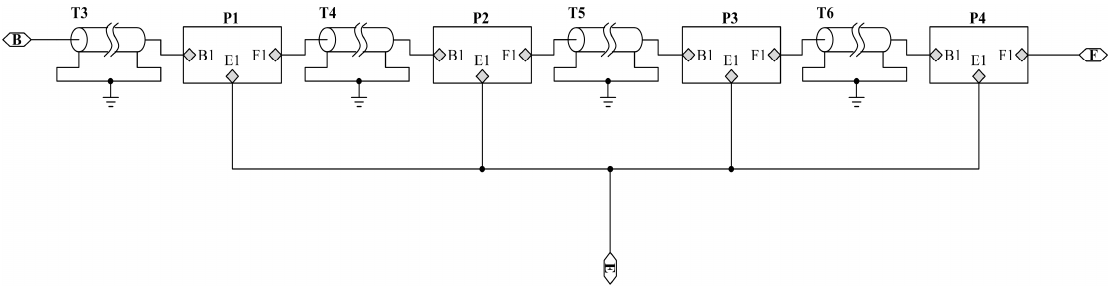
Figure 8. PSpice circuit model of a piezoelectric ceramic stack with electrodes.